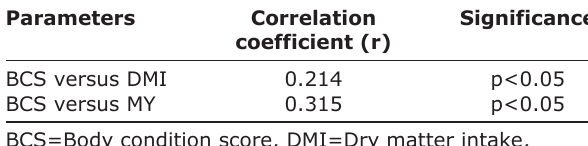
Table-3: Post-partum correlation coefficient (r) among BCS, DMI and MY.